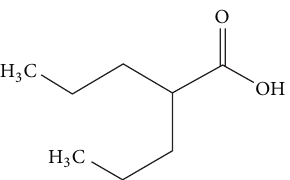
Figure 1: Chemical structure of valproate (VPA, 2-propylpentanoic